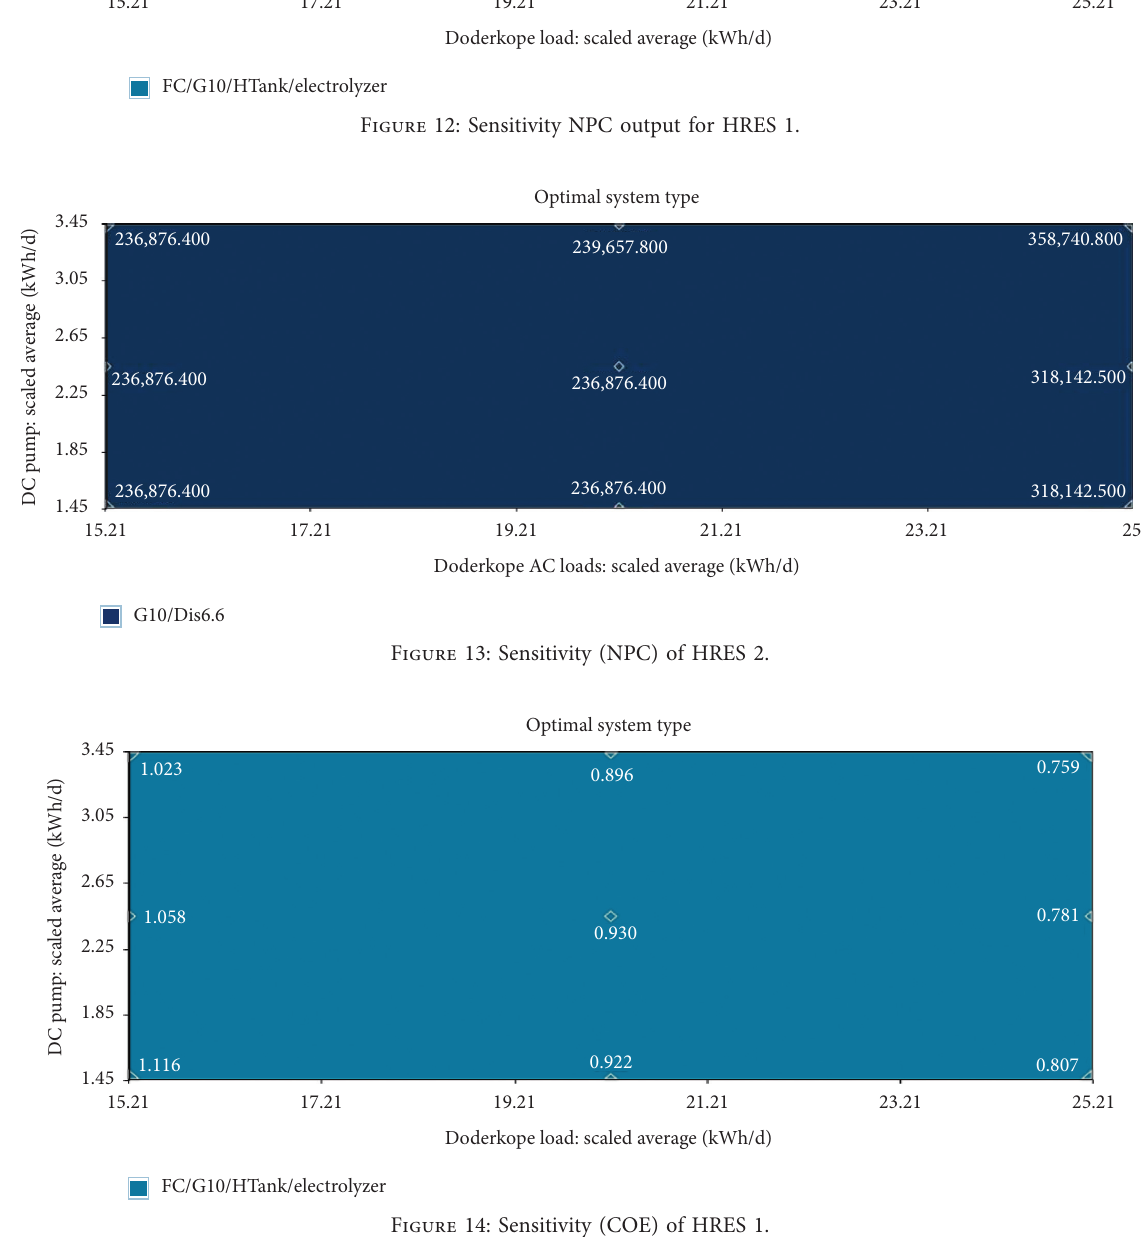
Figure 14: Sensitivity (COE) of HRES